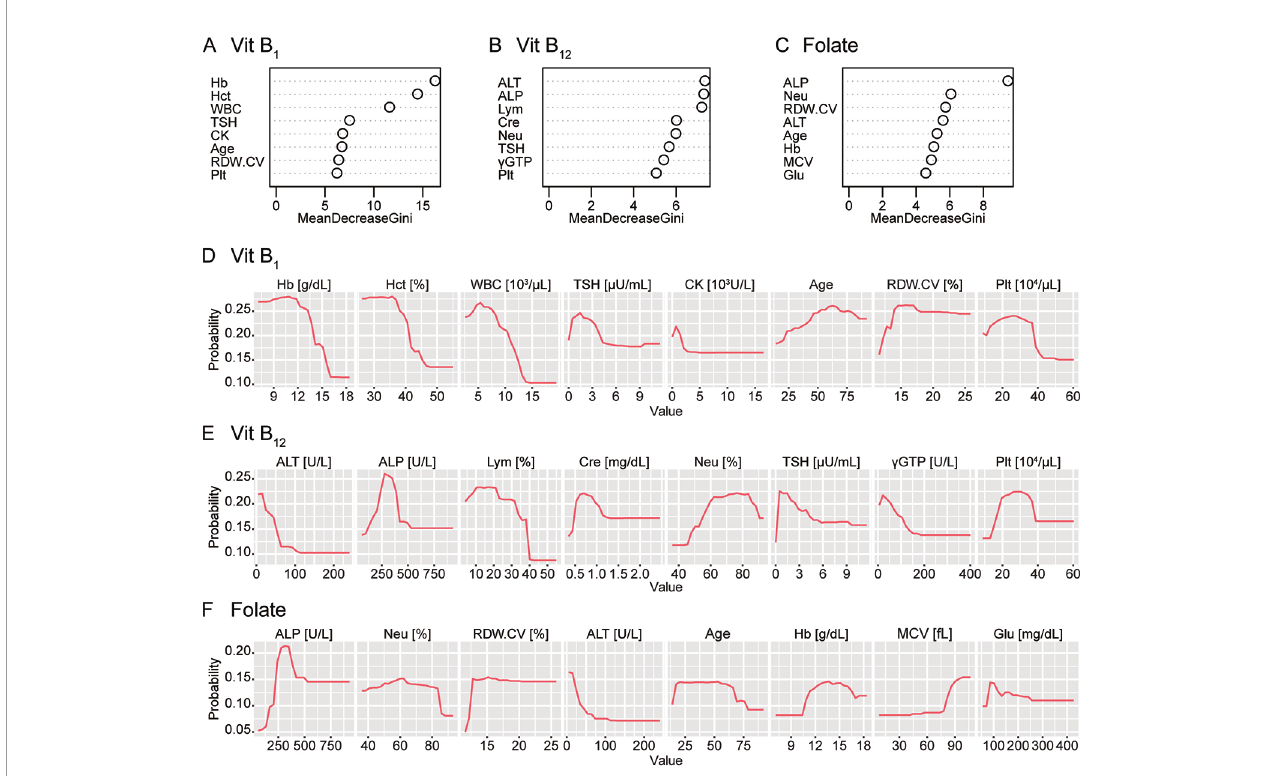
FIGURE 3 | Gini importance and partial dependence plots of vitamin B de fi ciencies. The Gini importance (A – C) and partial dependency plots of the probability of de fi ciency (D – F) are shown for the eight most important variables for vitamin B 1 , vitamin B 12 , and folate (vitamin B 9 ). Combined with these, this machine-learning classi fi er without hypothesis also provided further evidence of a relationship between vitamin B levels and the complete blood count while also indicating a potential association between these vitamins and alkaline phosphatase (ALP) or thyroid-stimulating hormone (TSH). Vit B 1 , vitamin B 1 ; Vit B 12 , vitamin B 12 ; Hb, hemoglobin; Hct, hematocrit; WBC, white blood cell count; CK, creatine kinase; RDW.CV, red blood cell distribution width-coef fi cient variation; Plt, platelet; ALT, alanine transaminase; Lym, lymphocyte fraction; Cre, creatinine; Neu, neutrocyte fraction; g GTP, g -glutamyltransferase; MCV, mean corpuscular volume; Glu, plasma glucose.